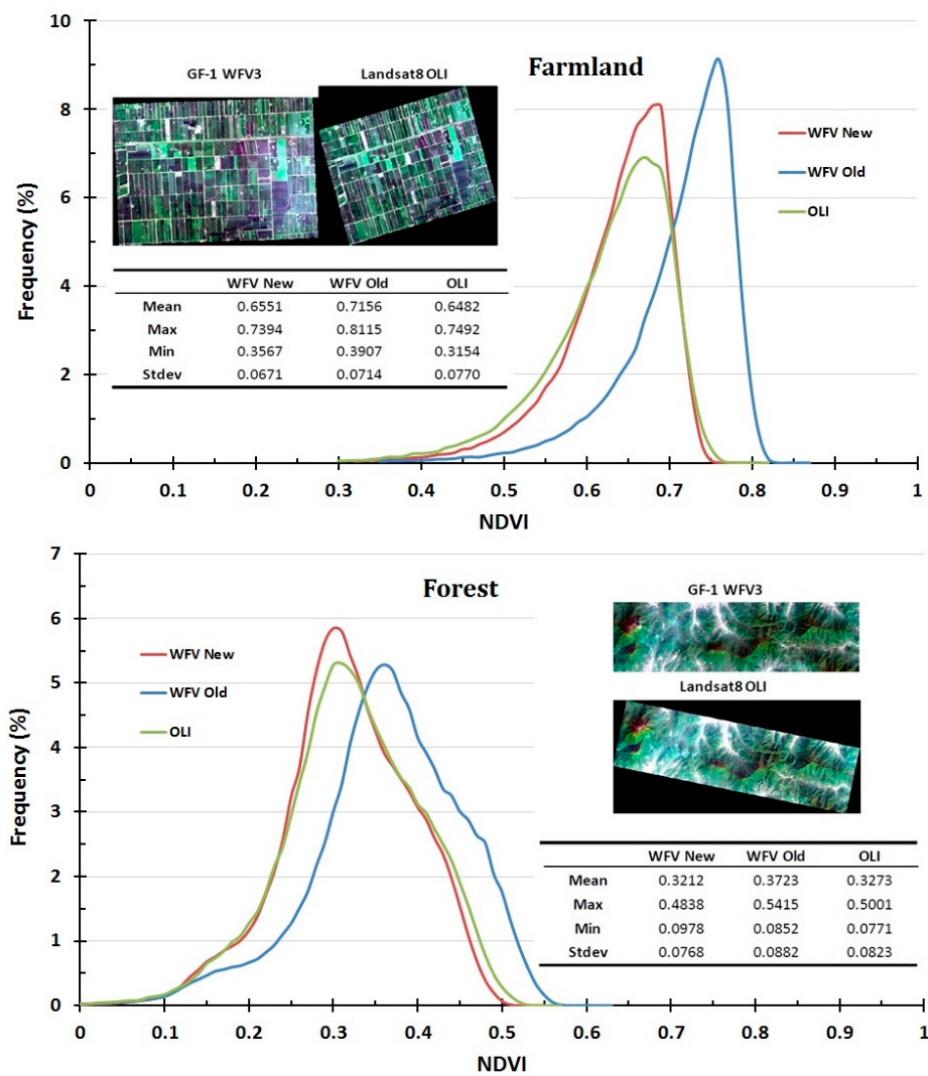
Figure 11. Comparison of the histograms and statistics of NDVI for WFV and OLI in typical farmland and forest, where both cross calibrated (new) and officially calibrated data (old) for WFV were